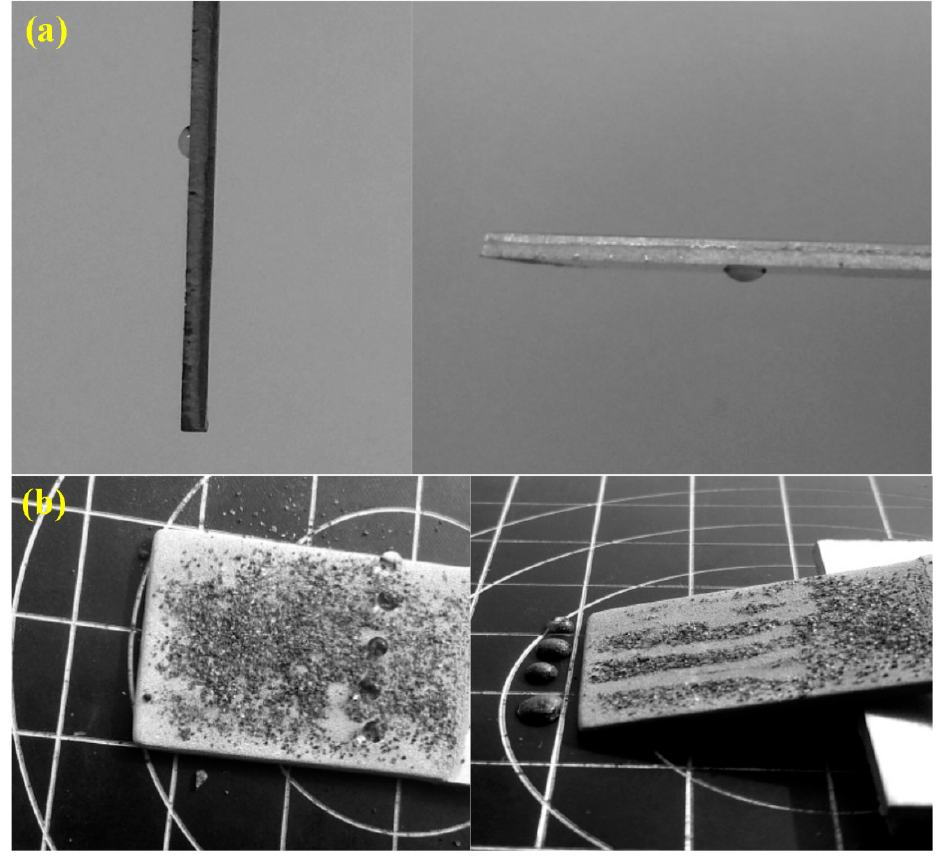
Figure 4. Self-cleaning performance of aluminum alloy samples with ( a ) OS and ( b ) BS obtained via a combination of SP, ECO, and fluoroalkylsilane (FAS) modification.